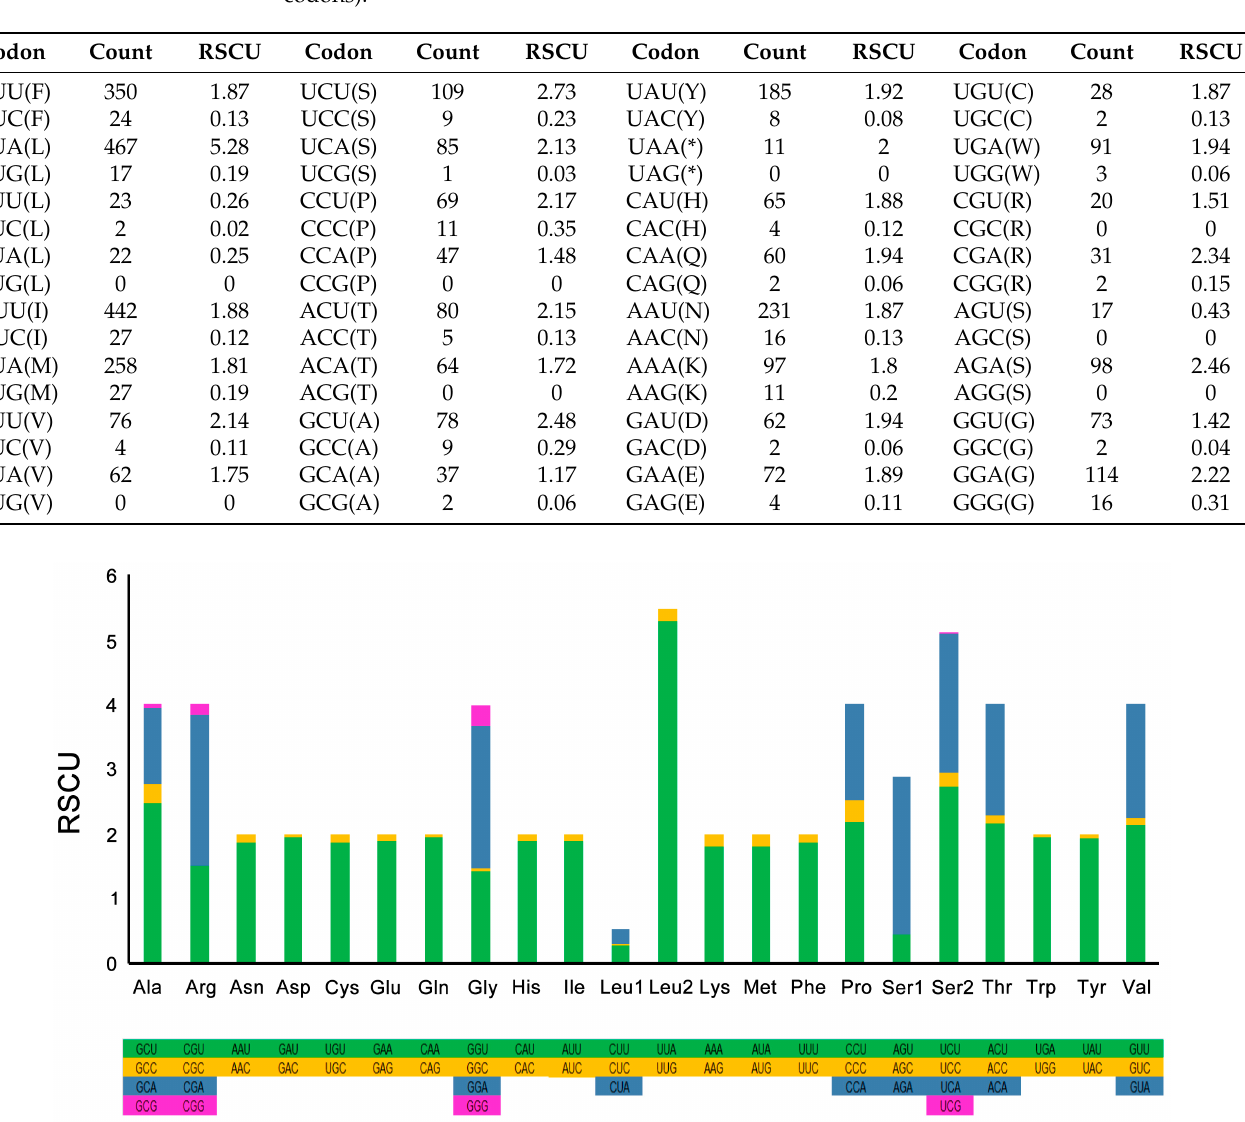
Figure 2. The relative synonymous codon usage (RSCU) in the mitogenome of C. perspectalis .